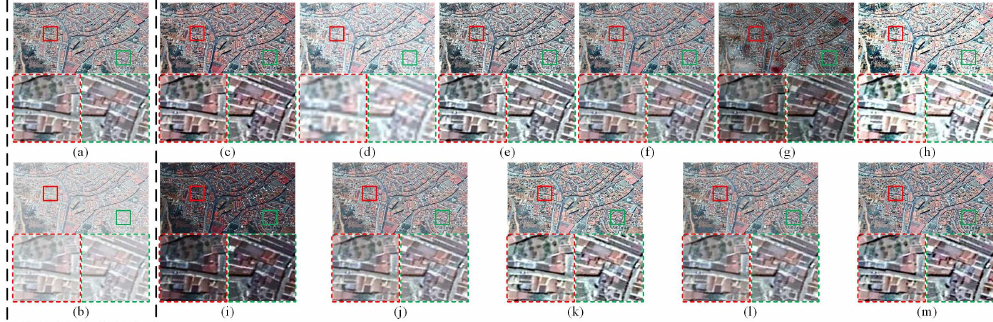
Figure 12. An image dehazing example of a remote sensing urban image from a synthetic hazy scene: ( a ) A haze-free image; ( b ) a synthetic hazy image; ( c ) DCP; ( d ) GPR; ( e ) AMP; ( f ) DEFADE; ( g ) WCD; ( h ) RRO; ( i ) MOF; ( j ) CAP; ( k ) HLM; ( l ) DN; ( m ) Proposed. Two partially enlarged images marked in red and green dotted frames correspond to the regions surrounded by red and green frames in the dehazed image.